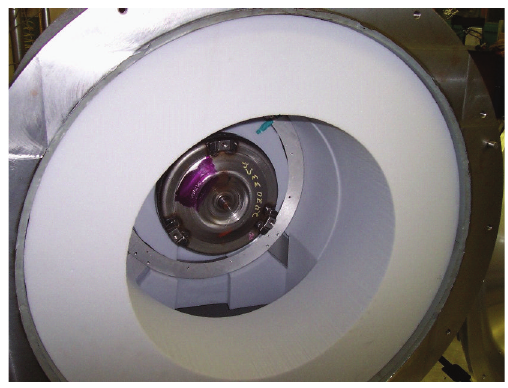
Figure 4: Torque converter, acoustical foam, and nearfield micro- phone configuration in test